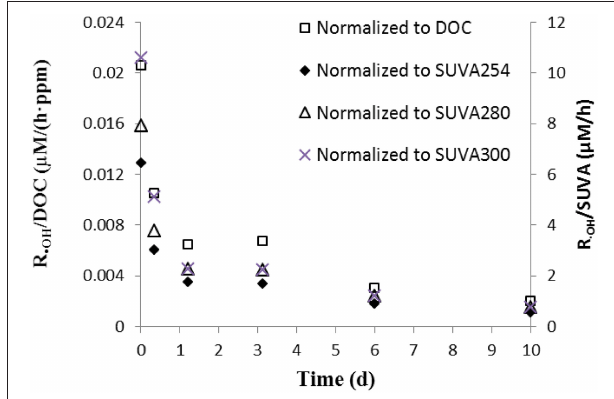
FIGURE 3 | •OH formation rate normalized to DOC and SUVA 254 in the aqueous leachate of degraded wood.